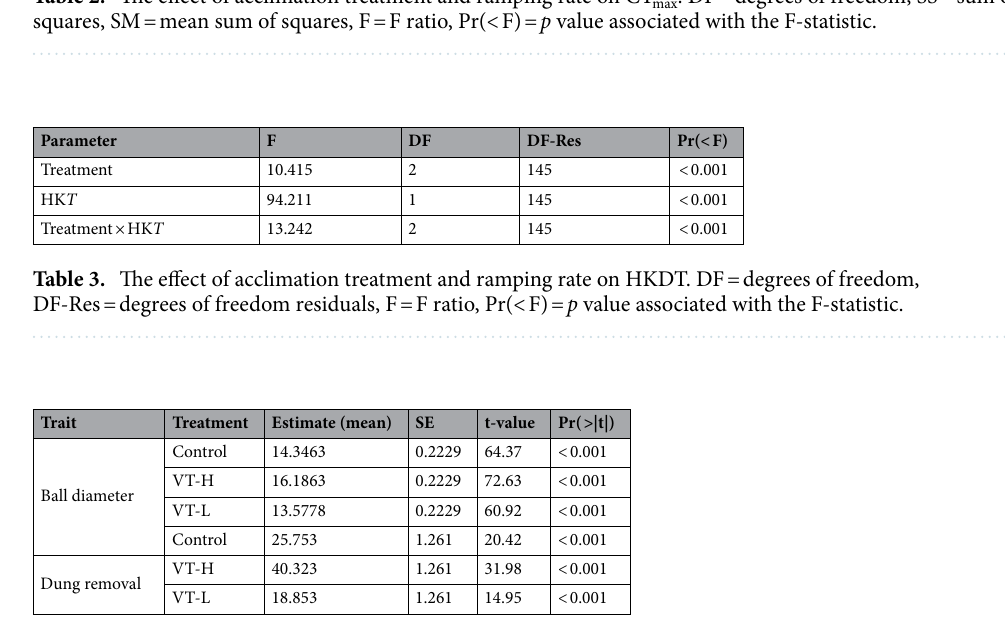
Table 4. Parameter estimations of variable high (VT-H) and variable low (VT-L) acclimation treatments on ball diameter and dung removal efficiency. Statistical significance was determined at p < 0.05.